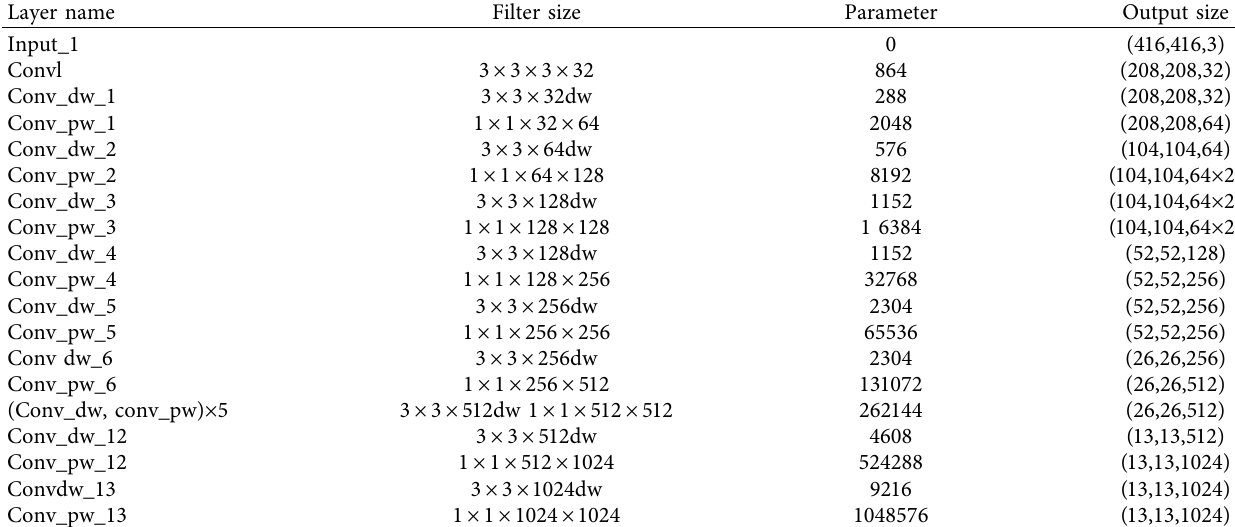
Figure 2: Traditional standard convolution and depth separable convolution. (a) Traditional standard convolution. (b) Depth separable convolution. Table 2: Improved YOLOv4 model backbone network